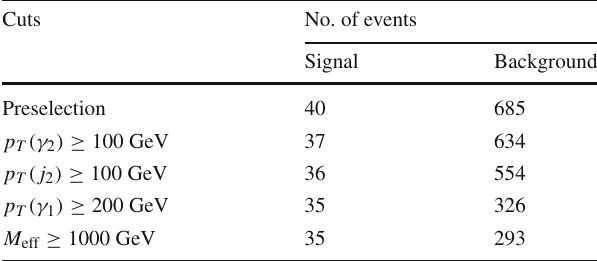
Table 6 The selectedevents after each step of selection criteria for BP2 with an integrated luminosity of 100fb − 1 Cuts No. of